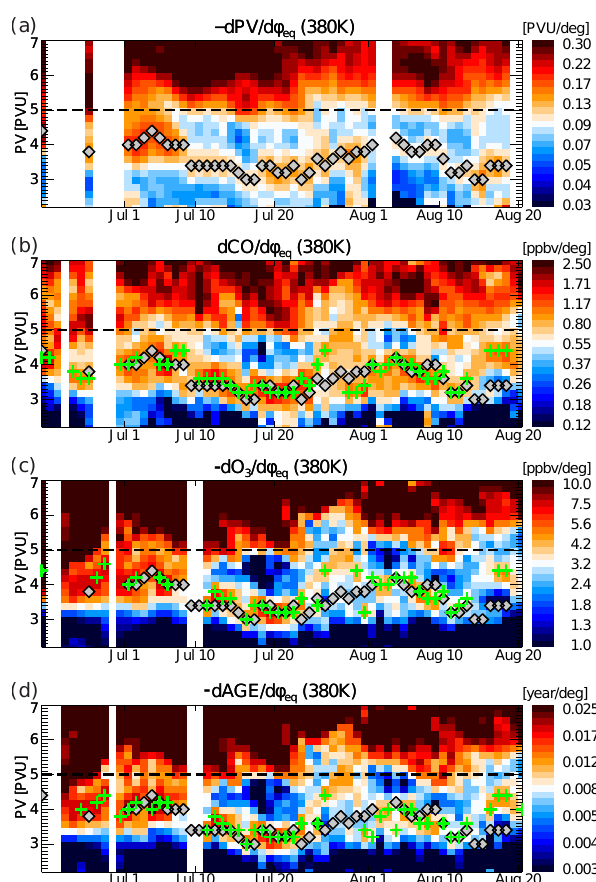
Figure 12. (a) Time evolution of the gradient of PV with respect to monsoon centered equivalent latitude φ eq as a function of PV for the period 20 June to 20 August 2011 at 380K (note the logarith- mic color scale). The same is shown for panels (b) CO, (c) O 3 , and (d) mean age. Symbols show the PV-gradient maximum (grey dia- monds), and the CO-gradient maximum (green crosses). The dashed line highlights 5PVU. Dates without a clear gradient maximum are left white.